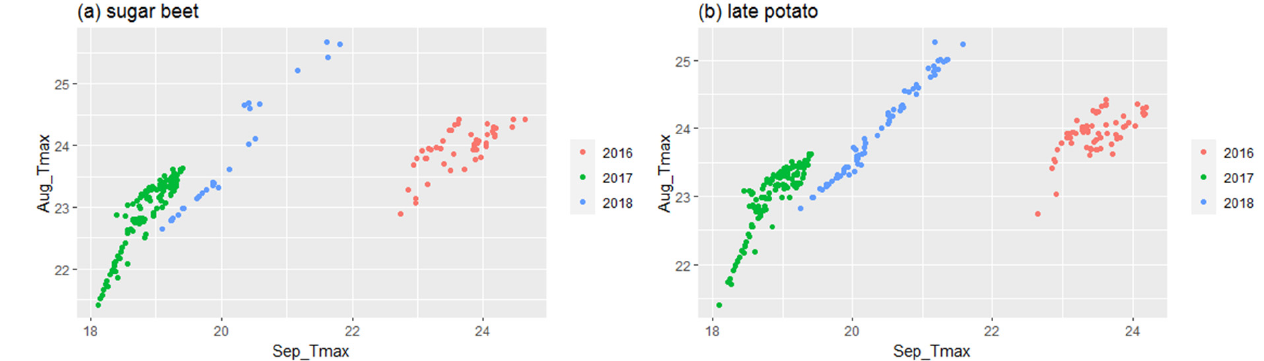
Figure 10. ( a ) Scatterplot: observed Tmax in August versus for Tmax in September for sugar-beet fields, ( b ) scatterplot: observed Tmax in August versus for Tmax in September for late-potato fields.